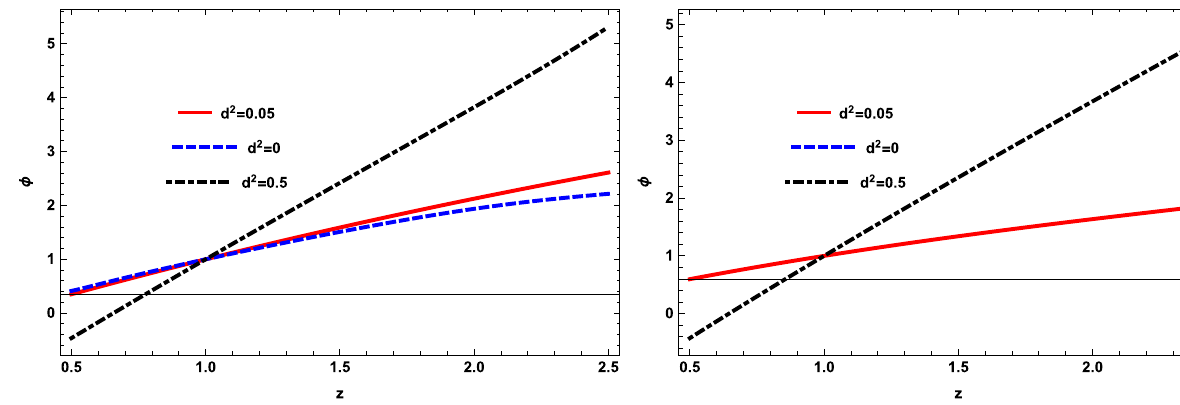
Fig. 37 Plot of φ verses z for u = 1 and u = 2 . 002 for tachyon scalar field model